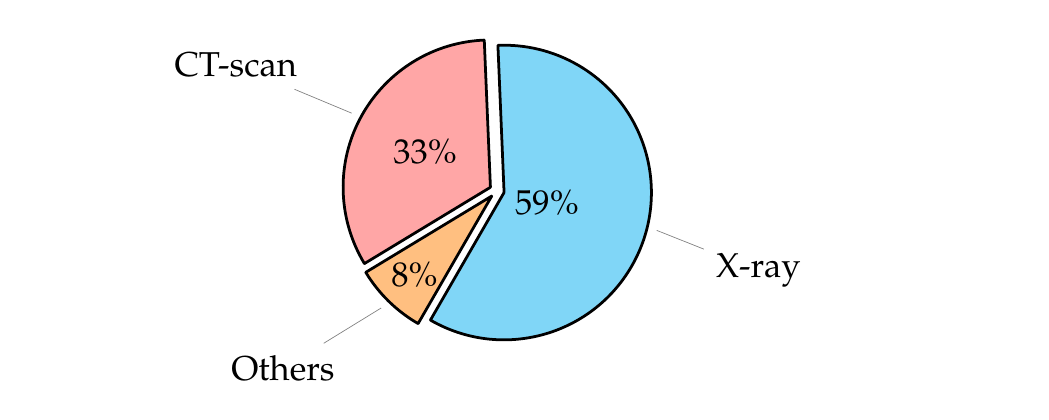
Figure 9. Image type of thoracic diseases distribution using deep learning in the recent years.